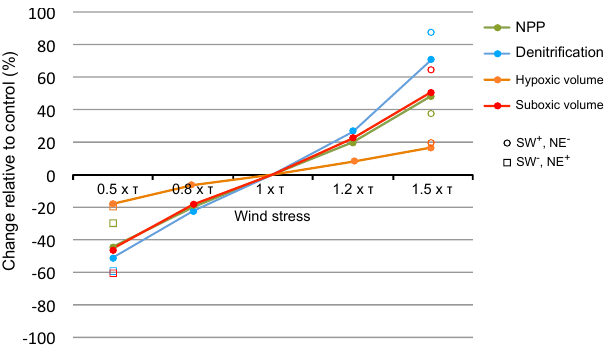
Figure 5. Biogeochemical response to monsoon wind intensity changes. Relative changes in response to monsoon wind inten- sity perturbations in net primary production (green), denitrification (blue), suboxic volume (red) and hypoxic volume (orange). Open circles (respectively, squares) indicate the results from the simula- tion where summer monsoon wind stress is increased (respectively, decreased) by 50% and winter monsoon wind stress is decreased (respectively, increased) by 50%.